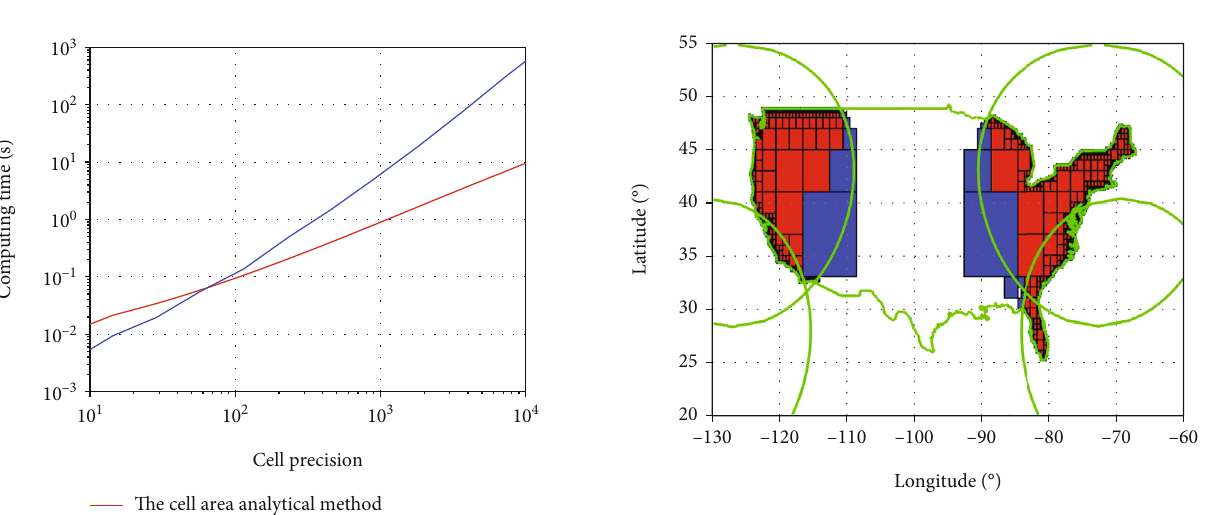
Figure 13: The coverage region of simulation for target-2.